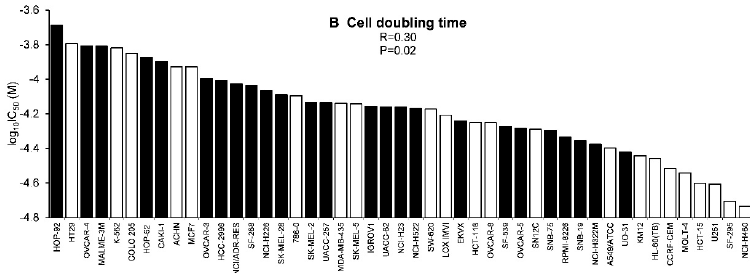
Figure 5. Ranked order of log 10 IC 50 values for scopoletin of NCI cell lines in comparison to the mutational status of ( A ) pan- RAS ( H- , K- , N-RAS ) (solid bars mutated RAS , open bars wild-type RAS ) and ( B ) cell doubling times (solid bars: slowly growing cell lines with doubling times >30 h. Open bars: rapidly growing cells with doubling times <30 h). Significance levels were calculated using two-sided Mann-Whitney’s U-test.